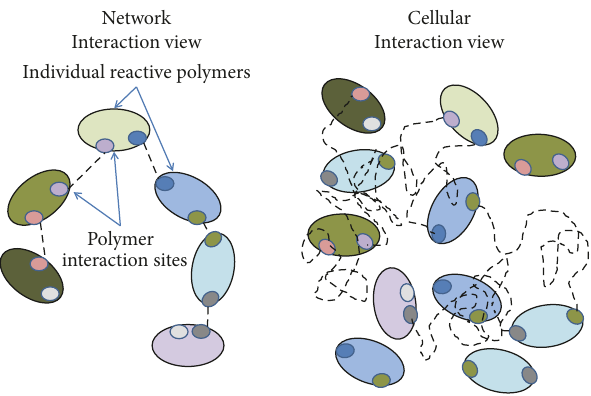
Figure 1: Simplified network interaction view (a) and cellular interaction view (b) of metabolic polymers in the cellular environ- ment.Metabolicnetworkstructureismaintainedbycomplementary interaction docking sites that help to narrow down interactions among polymers to specific